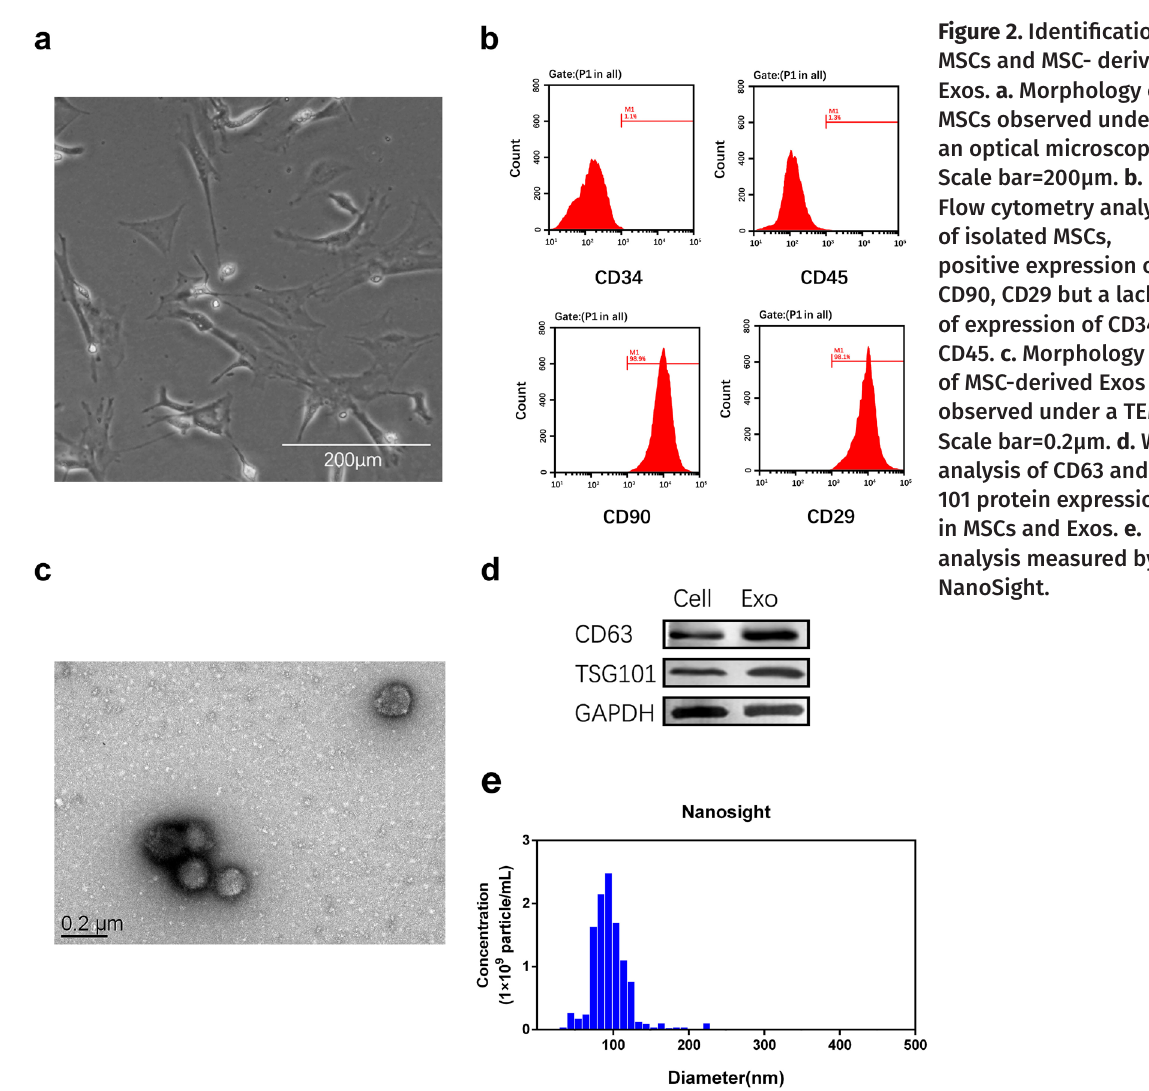
Figure 2. Identification of MSCs and MSC- derived Exos. a. Morphology